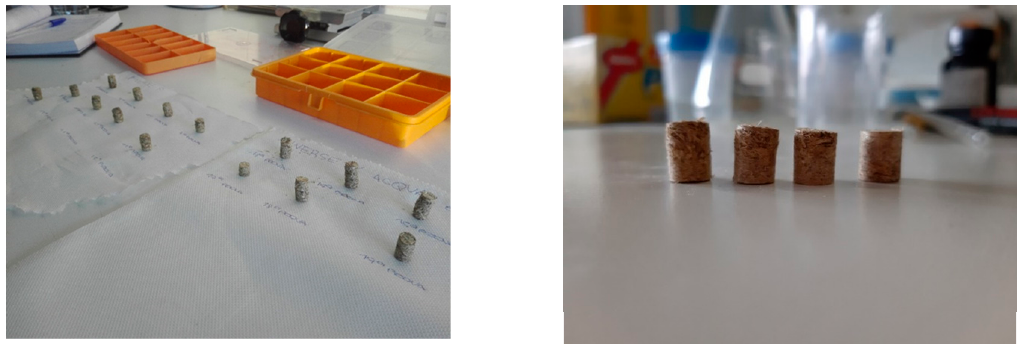
Figure 2. Pellets produced using the single press.